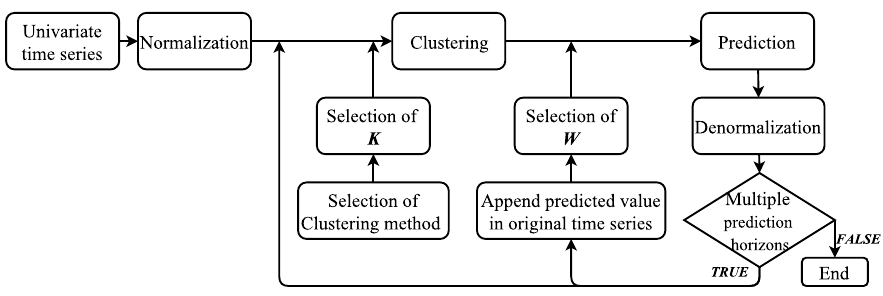
Figure 1. PSF algorithm block diagram (Source: